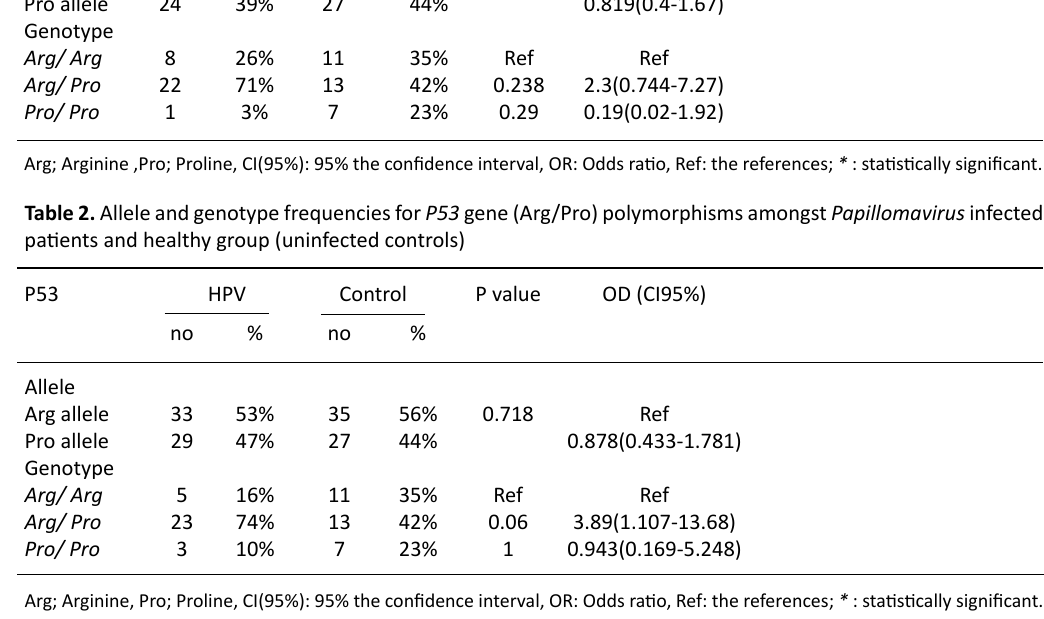
Table 3. Mutation frequencies of P53 (Arg/Pro) polymorphisms among Molluscum contagiosum positive patients and healthy (uninfected controls) P53